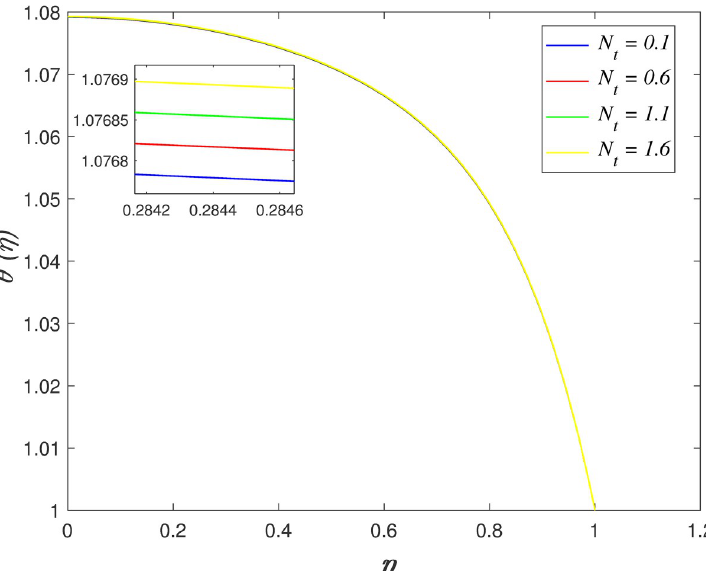
Fig 21. Impact of N t on